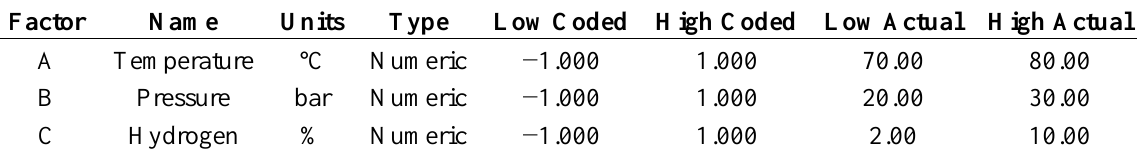
Table 1. Coded levels for independent variables used in the experimental design.